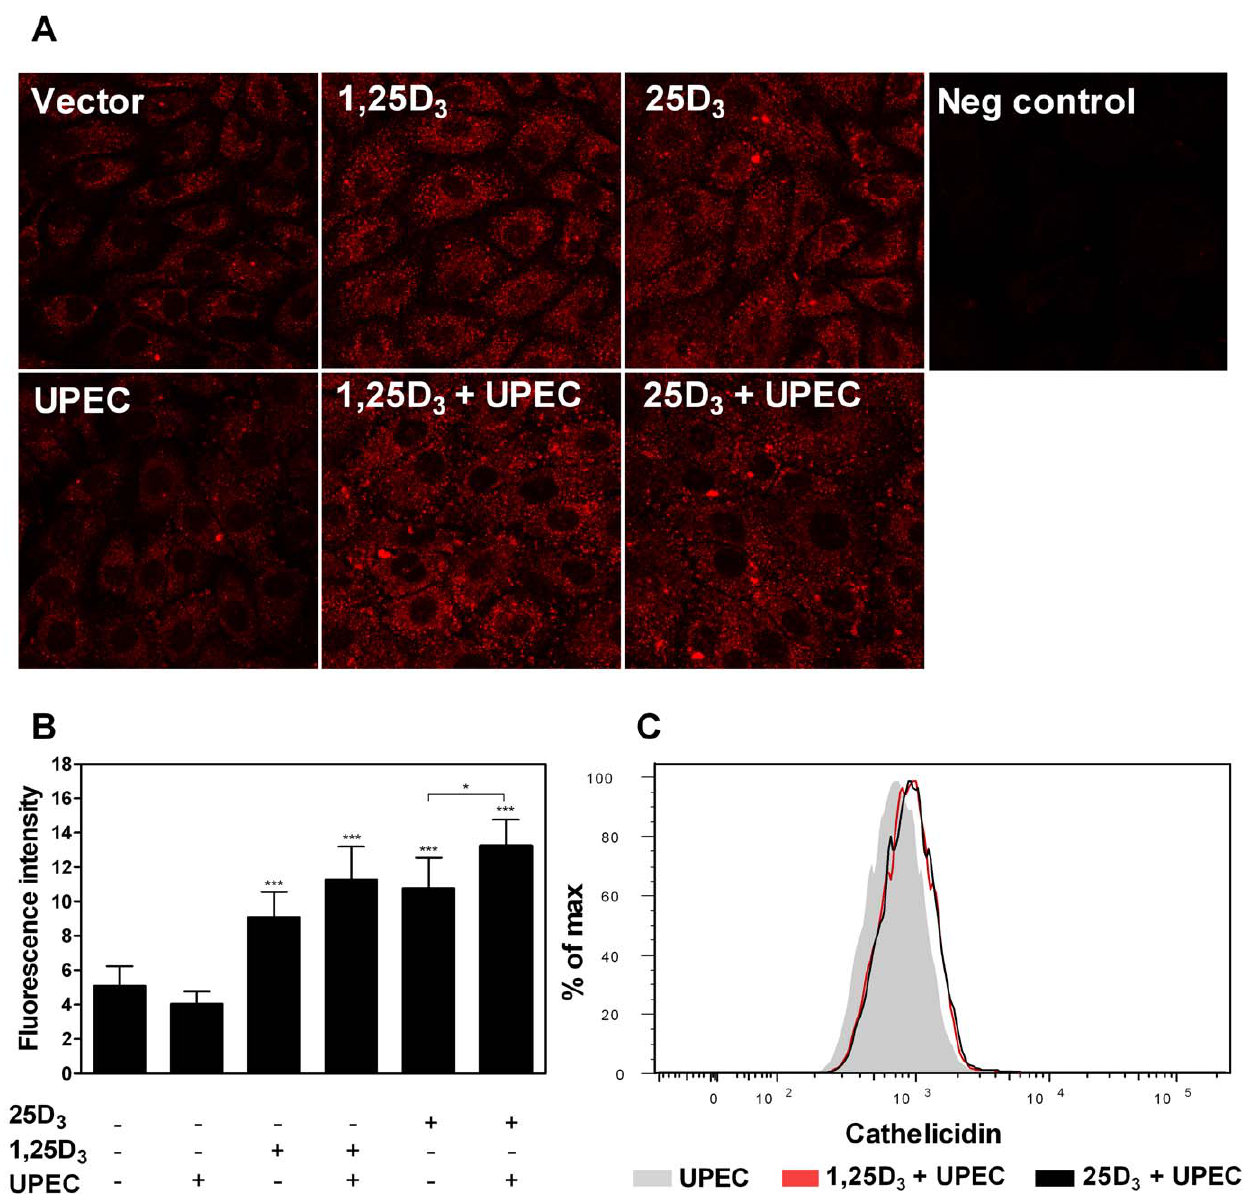
Figure 5. 1,25D 3 or 25D 3 in combination with E.coli increased cathelicidin protein in bladder epithelial cells. Production of cathelicidin increased in TERT-NHUC bladder cells after treatment with 1,25D 3 or 25D 3 , and was further increased by infection with E. coli CFT073 (UPEC). Images are captured at 6 63 magnification and depict an area corresponding to 119 6 119 m m ( A ). The control image (Neg control) is shown in the right upper panel. Fluorescence intensity was quantified and is presented as mean values with standard deviation; *** P , 0.001, * P , 0.05 (ANOVA with Dunnett’s post-test) ( B ). An increase in cathelicidin protein was also recorded by flow cytometry in E. coli -infected TERT-NHUC bladder cells treated with 1,25D 3 or 25D 3 . Grey is vector + E. coli , red is 1,25D 3 10 2 8 M + E. coli and black is 25D 3 10 2 7 M + E. coli ( C ).